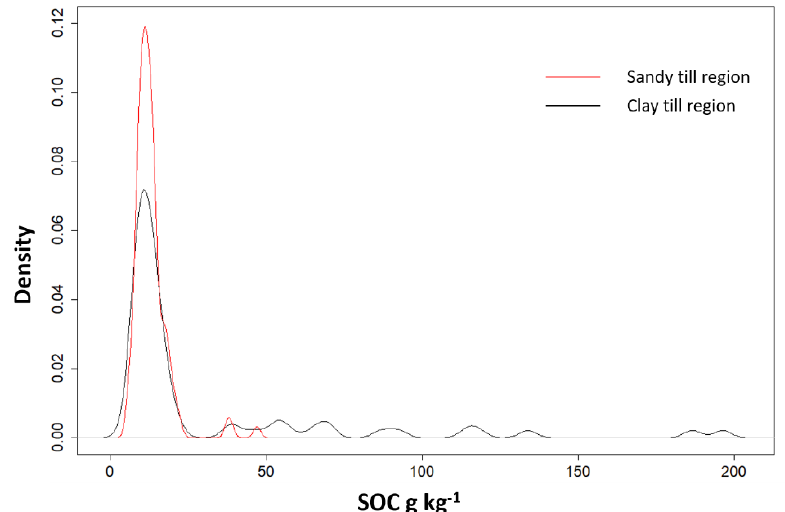
Figure 1. RGB (red: 665 nm; green: 560 nm; blue: 490 nm) satellite image acquired by Sentinel-2 sensor of the study area with location of the soil samples of the Mecklenburg-West Pomerania (MWP) dataset.The white frame is a zoom of field 1, 2 and 3. Remote Sens. 2019 , 11 , x FOR PEER REVIEW